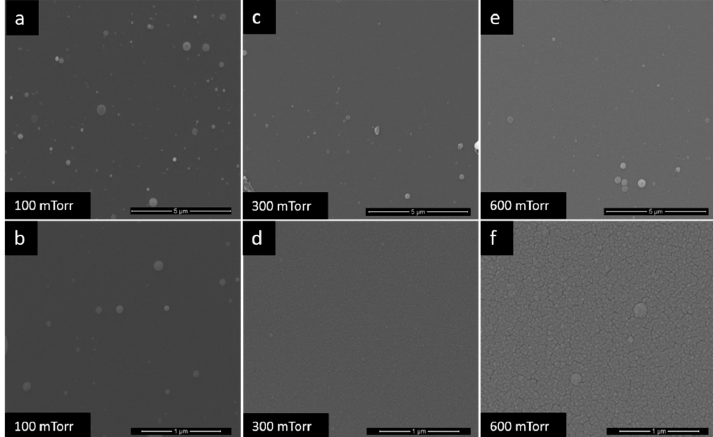
Figure 4. SEM images of the Pd films at ( a ) and ( b ) − 100 mTorr, ( c ) and ( d ) − 300 mTorr, ( e ) and ( f ) − 600 mTorr.